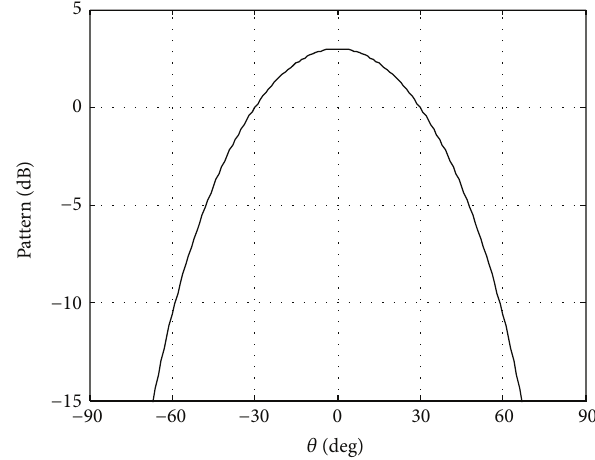
Figure 2: Radiation pattern of a 2-element linear